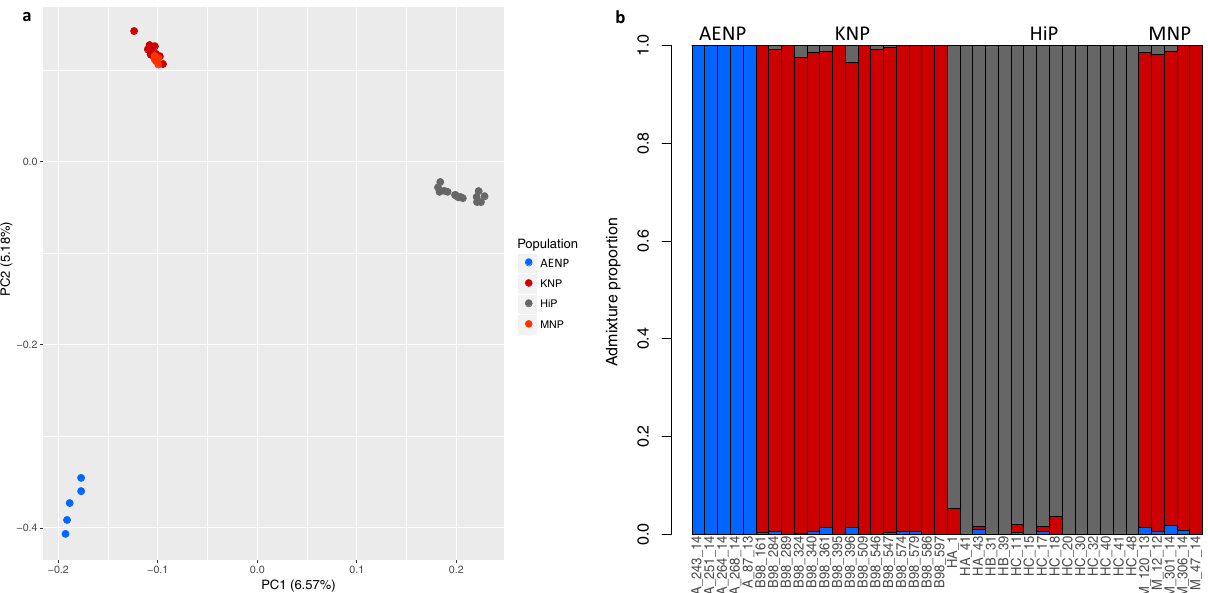
Figure 3. Population structure of buffalo included in this study. ( a ) Principal component analysis (PCA) plot. The percentage of variation explained by each principal component (PC) is shown in parenthesis on the x- and y-axis. ( b ) Individual assignment plot of the NGSadmix analysis at K = 3. Plots for values of K = 2, 4, 5 and 6 are shown in Supplementary Fig.